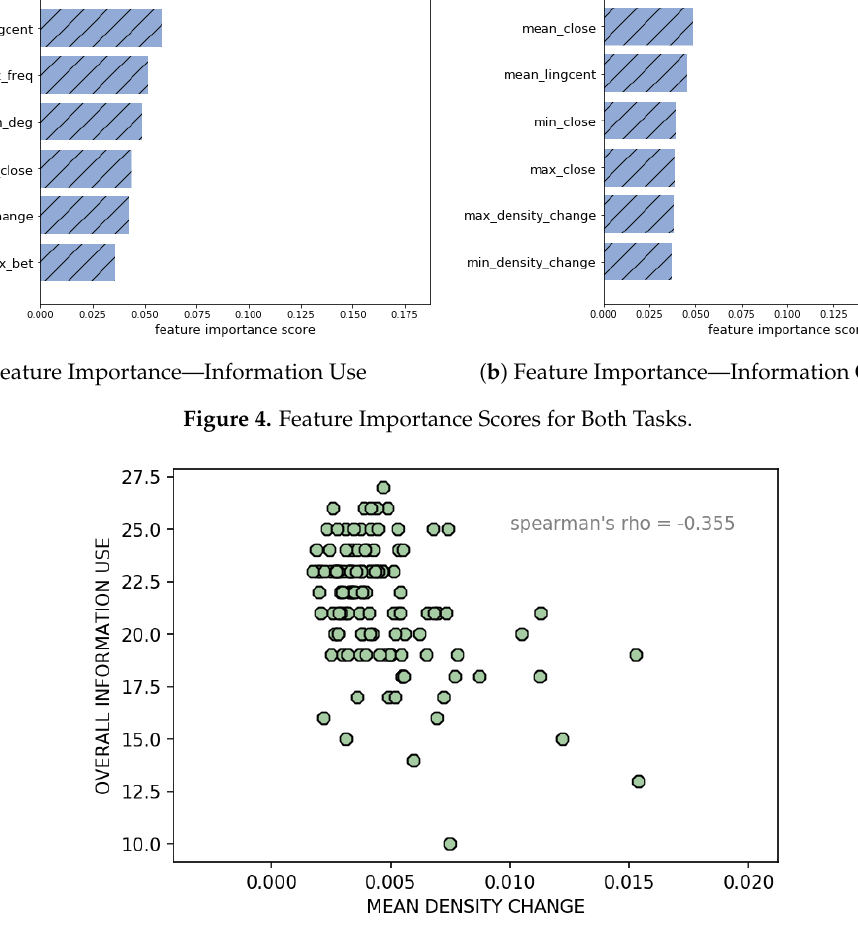
Figure 5. Network Density Change vs. Information Use Score. Table 2. Multivariate LR Coefficients for Top